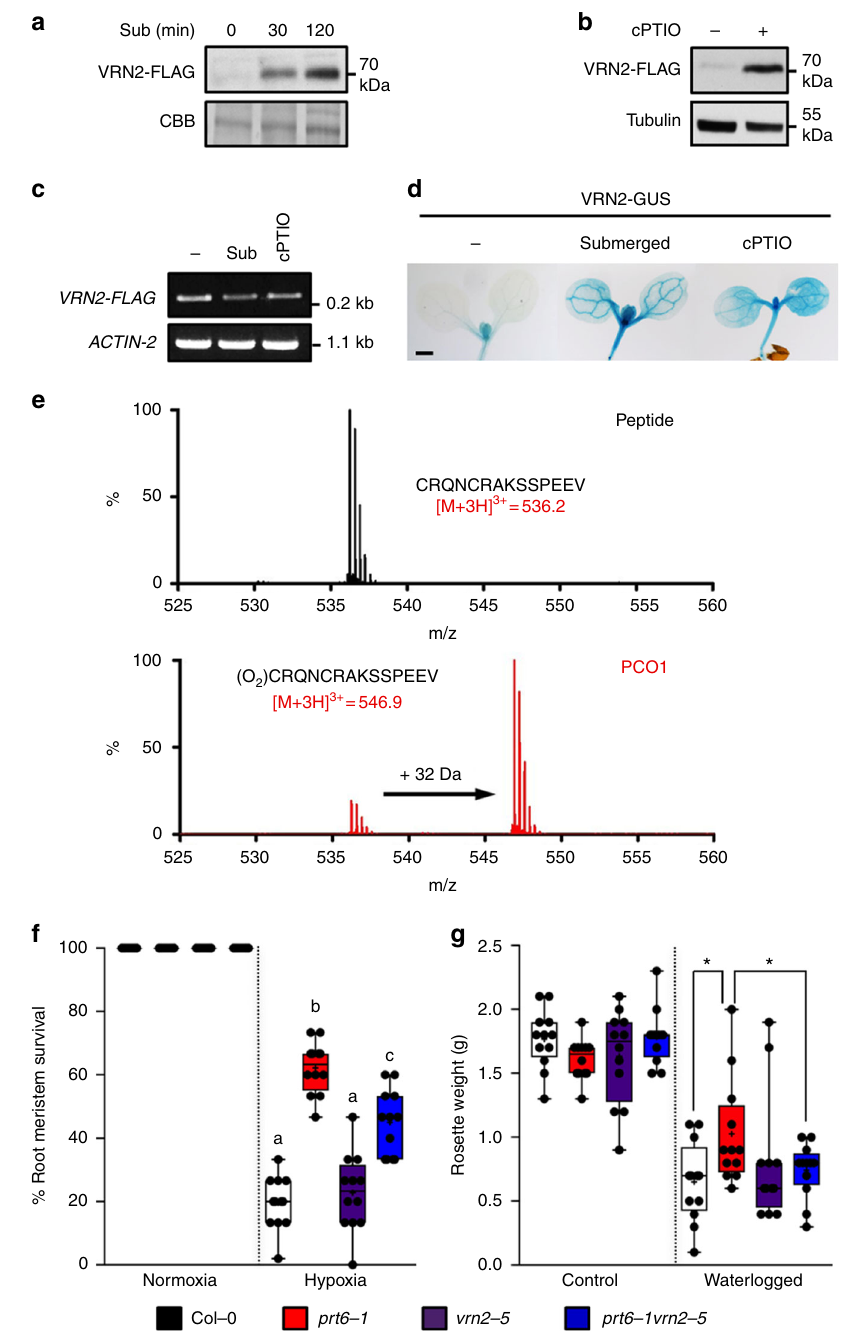
Fig. 2 VRN2 is regulated by O 2 and NO availability and positively regulates hypoxia tolerance. a VRN2-FLAG protein accumulation during a